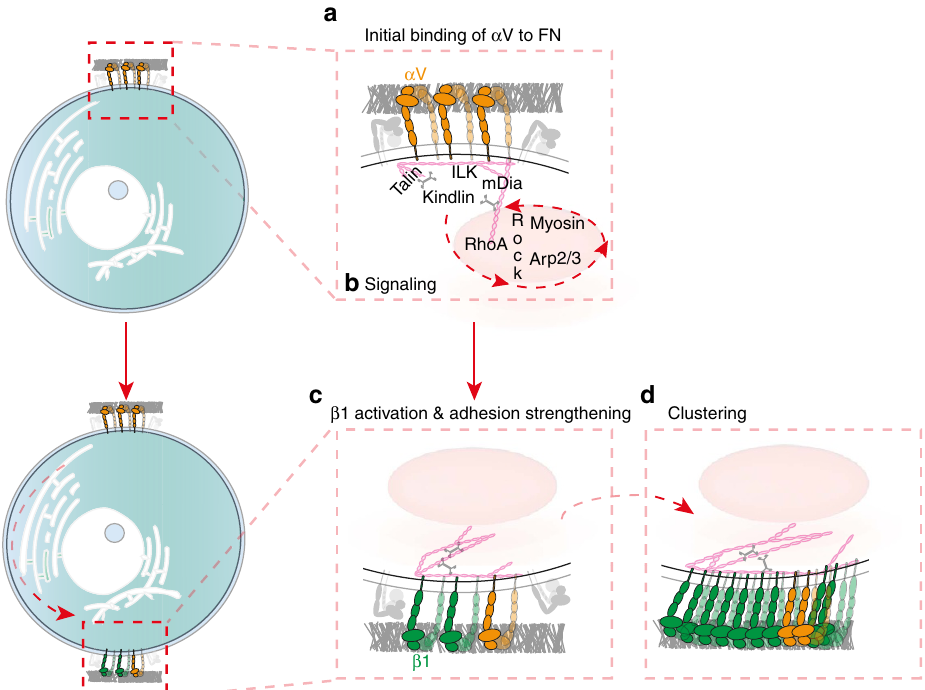
Figure 5 | a V-class integrins compete with a 5 b 1 integrins for the binding of FN and crosstalk to a 5 b 1 integrins to strengthen adhesion to FN. ( a ) As fibroblasts initiate contact with FN, a V-class integrins successfully compete with a 5 b 1 integrins to bind the substrate. ( b ) This binding engages a V-class integrins and recruits integrin-associated proteins such as talin, kindlin, ILK and formins to the adhesion site. Upon recruitment, the integrin-associated proteins mediate and strengthen the attachment of integrins to the actomyosin cortex. To strengthen fibroblast adhesion, activated a V-class integrins via the RhoA/ROCK/myosin-II and Arp2/3 pathway signal to ( c ) a 5 b 1 integrins to bind FN thereby forming new adhesion sites. ( d ) Consequently, a 5 b 1 integrins cluster to strengthen adhesion. This crosstalk eventually leads to the formation of nascent adhesions. Recent structural investigations suggested that inactive a 5 b 1 integrins can co-exist in bent and unbent conformations, while inactive a V-class integrins have shown to be bent 51 . Thus, for